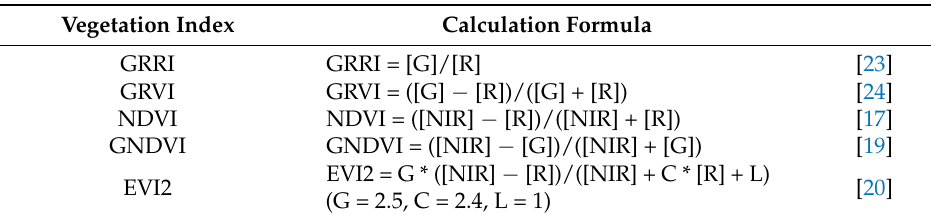
Table 5. Calculation formulas for five vegetation indices: [G], [R], [NIR] are reflectance of each band. Vegetation Index